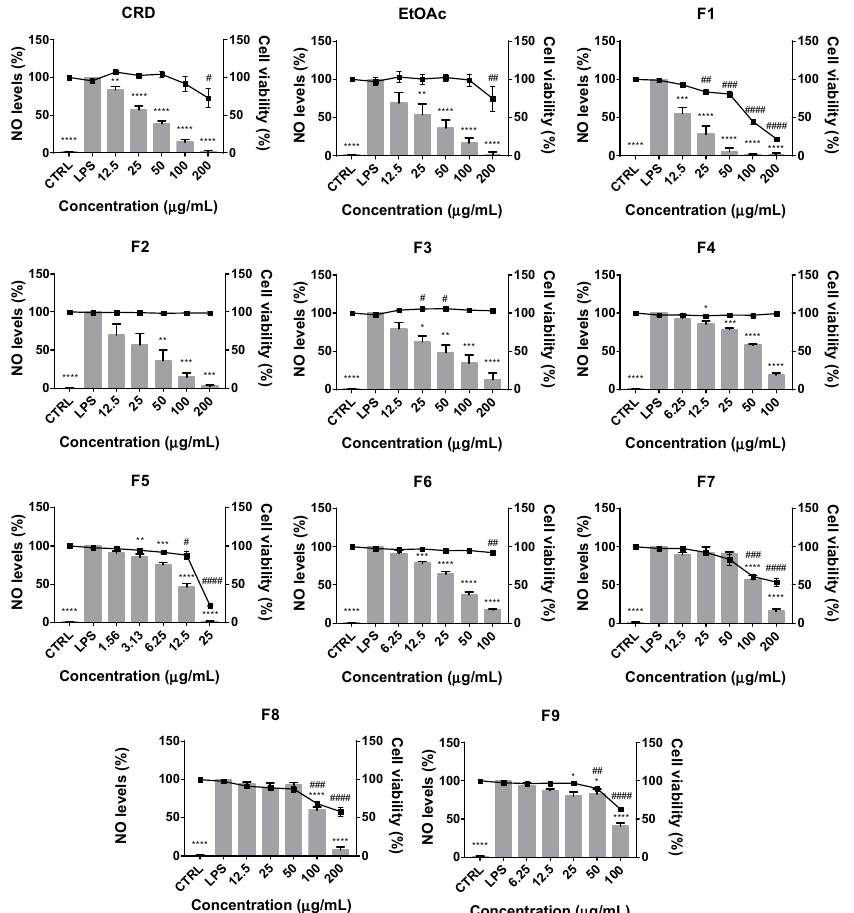
Figure 1. Effects of F. vesiculosus crude extract (CRD), ethyl acetate fraction (EtOAc) and subsequent subfractions (F1–F9) on the NO • production (grey bars) and viability ( ) of LPS-stimulated Raw 264.7 cells. Data represent the mean ± SEM from at least 3 independent experiments. * p < 0.05, ** p < 0.01, *** p < 0.001 and **** p < 0.0001, indicate that NO • production is significantly different from the positive control (with LPS) and # p < 0.05, ## p < 0.01, ### p < 0.001 and #### p < 0.0001 indicate that cells viability are statistically different from the negative control (CTRL, without LPS), as determined by one-way ANOVA followed by Dunnet’s post hoc